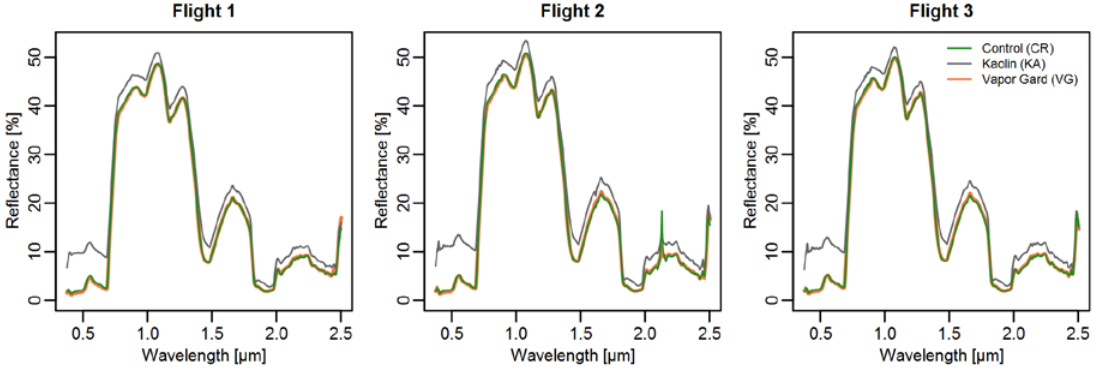
Figure 6. VNIR/SWIR mean reflectance spectra from HyPlant ’s dual-channel module.